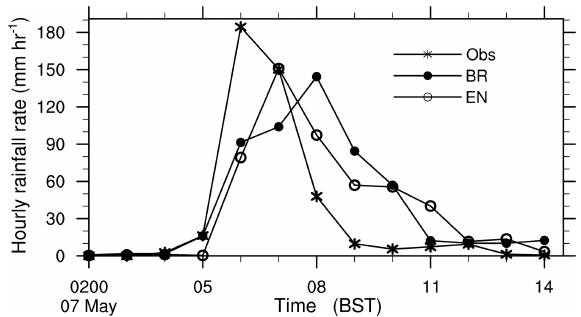
Figure 4. Time series of hourly rainfall rates (mmh − 1 ) from rain gauge observations ( ∗ ) and simulated with the EN scheme ( ◦ ) and the BR scheme ( • ) near Jiulong during the period of 20:00BST 6 May–14:00BST 7 May 2017 (see Fig. 3 for their